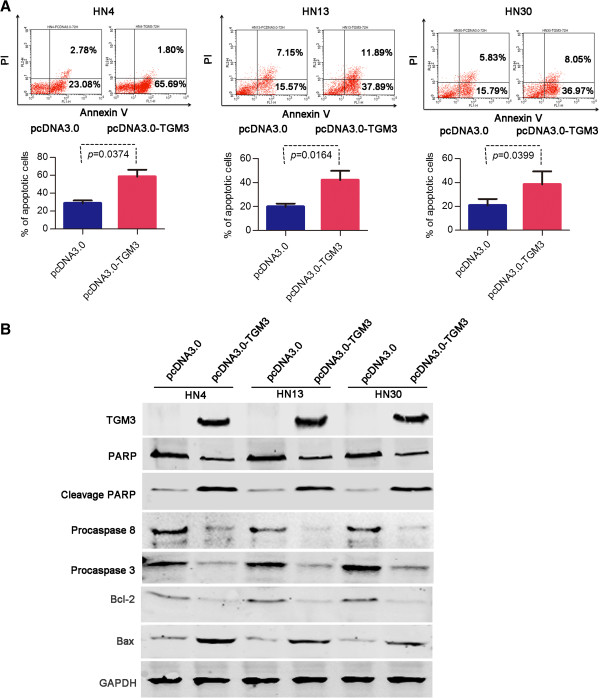
The effect of TGM3 on HNSCC cell apoptosis. (A) The proportion of apoptotic cells was markedly increased (lower right fraction) in TGM3-transfected HN4, HN13 and HN30 cells, relative to the mock-transfected control cells, as detected by PI and Annexin V staining. (B) The change in the apoptosis-related proteins full-length PARP, cleaved PARP, procaspase-3, procaspase-8, Bcl-2 and Bax was assessed by western blotting after transient transfection with the pcDNA3.0-TGM3 and pcDNA3.0 vector for 72 hours.